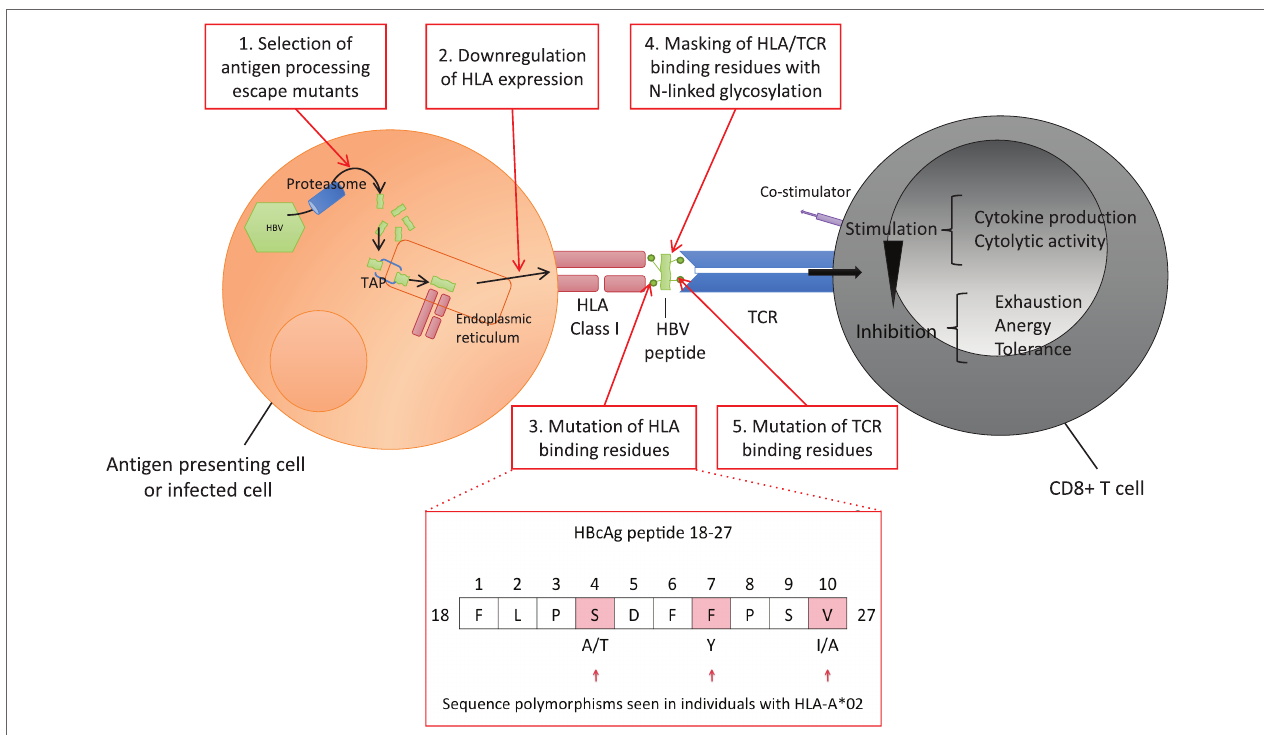
FigURe 3 | Hepatitis B virus (HBV) evasion of the host CD8 + T cell-mediated immune response. Viral peptides are processed into 7–12 mers by proteasomal degradation and are transported via the Transporter associated with Antigen Processing (TAP) into the endoplasmic reticulum. Peptides containing an appropriate motif are bound by human leukocyte antigen (HLA) class I molecules and transported to the cell surface for expression (92). Each T cell receptor (TCR) binds a range of specific HLA-peptide combinations. TCRs are concentrated on the cell surface over time at an “immunological synapse” triggering intracellular signaling (93). HBV can potentially escape the host CD8 + response at a number of points. 1. Evading antigen processing, 2. Downregulating presentation (37–40), 3. Altering HLA binding residues (54–56, 94), 4. Masking HLA epitope with N-linked glycosylation (NLG) sites (32, 95), 5. Altering TCR binding residues of the epitope (10, 96–99). Examples of polymorphic sites in HBV core antigen HLA-A*02 restricted FV10 epitope (residues 18–27) are highlighted